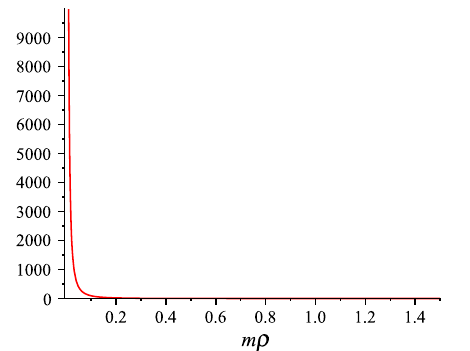
Fig. 2 Graphic for the function f ( m ρ) , which gives the induced mag- netic field outside a solenoid The function (39) is always positive, as one can see